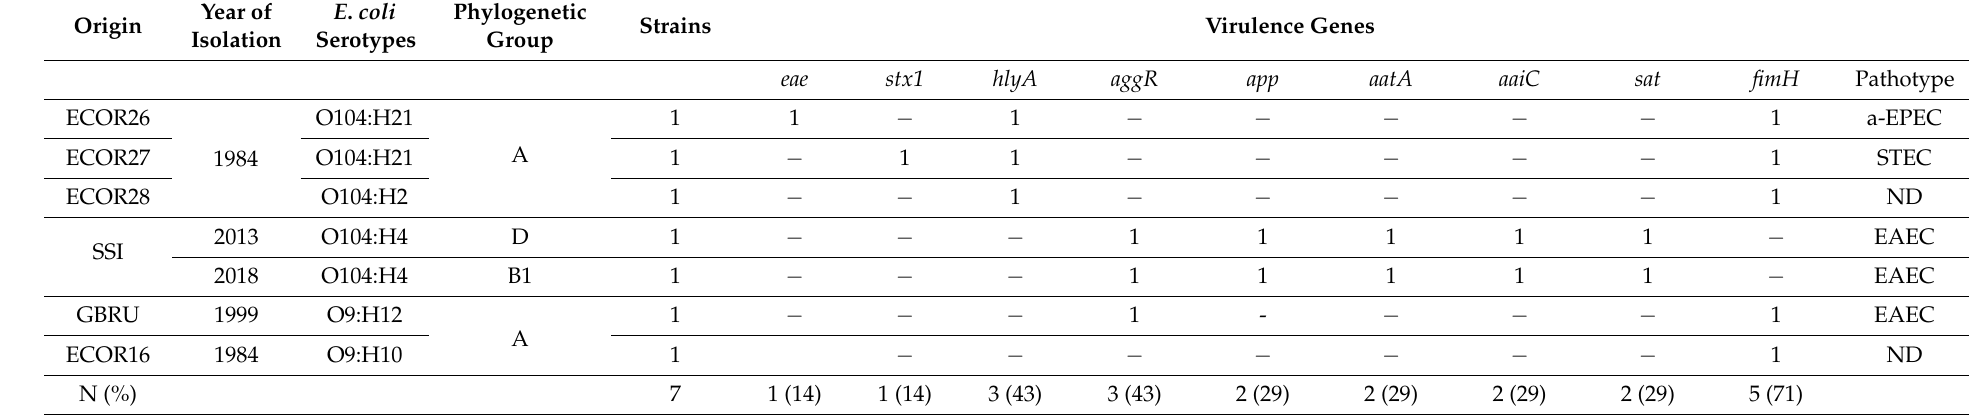
Table 4. Serotypes, phylogenetic groups and virulence genes in E . coli O104 ECOR and references